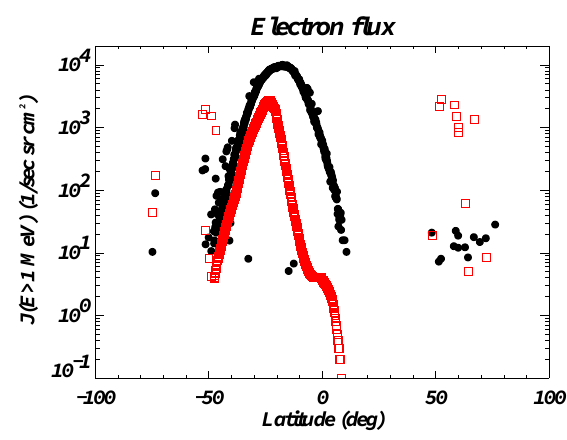
Fig. 3. Flux of energetic (E > 1MeV) electrons measured by the CPD (round) and AE8 model prediction (square) as a function of latitude on day 100 since 1st January 1999, at 14:52 UT. Typical statistical uncertainties on CPD electron fluxes amount to 30%, but the systematic error is considered